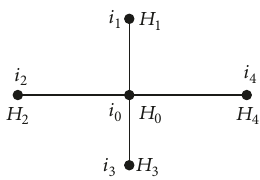
Figure 1: A unit in discrete fracture